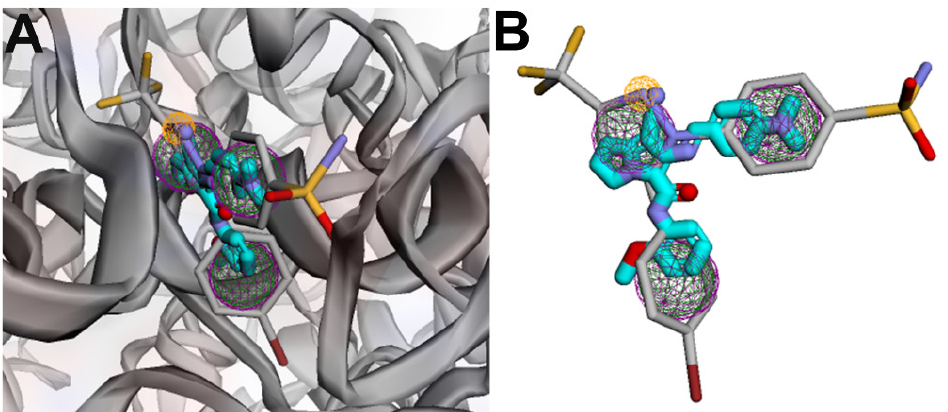
Figure 5. The binding site of SC-558 (shown as sticks colored by element) into COX-2: ( A ) 3D binding mode of SC-558 into COX-2 overlaid with hit1 (cyan sticks); ( B ) 3D overlay of SC-558 overlaid with hit1 (cyan sticks).